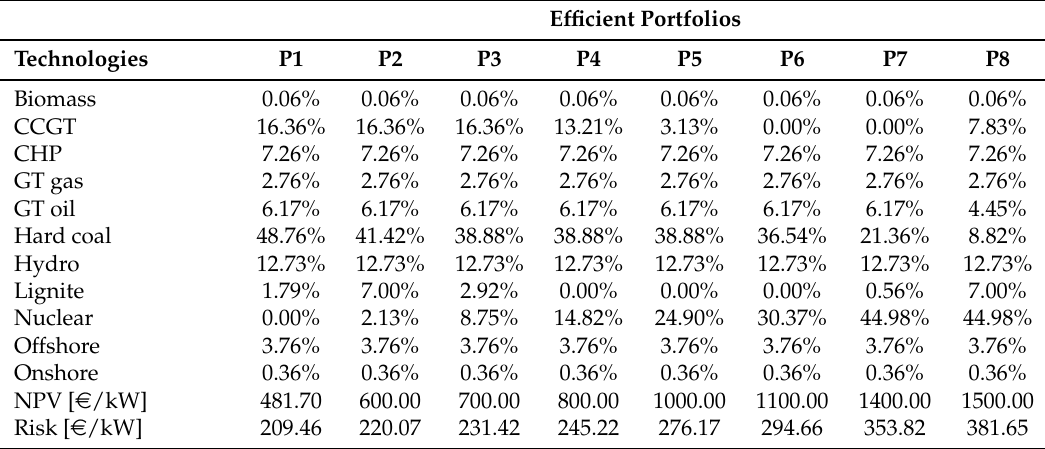
Table A10. Efficient portfolios according to the SMAD Model for existing technologies combined with new